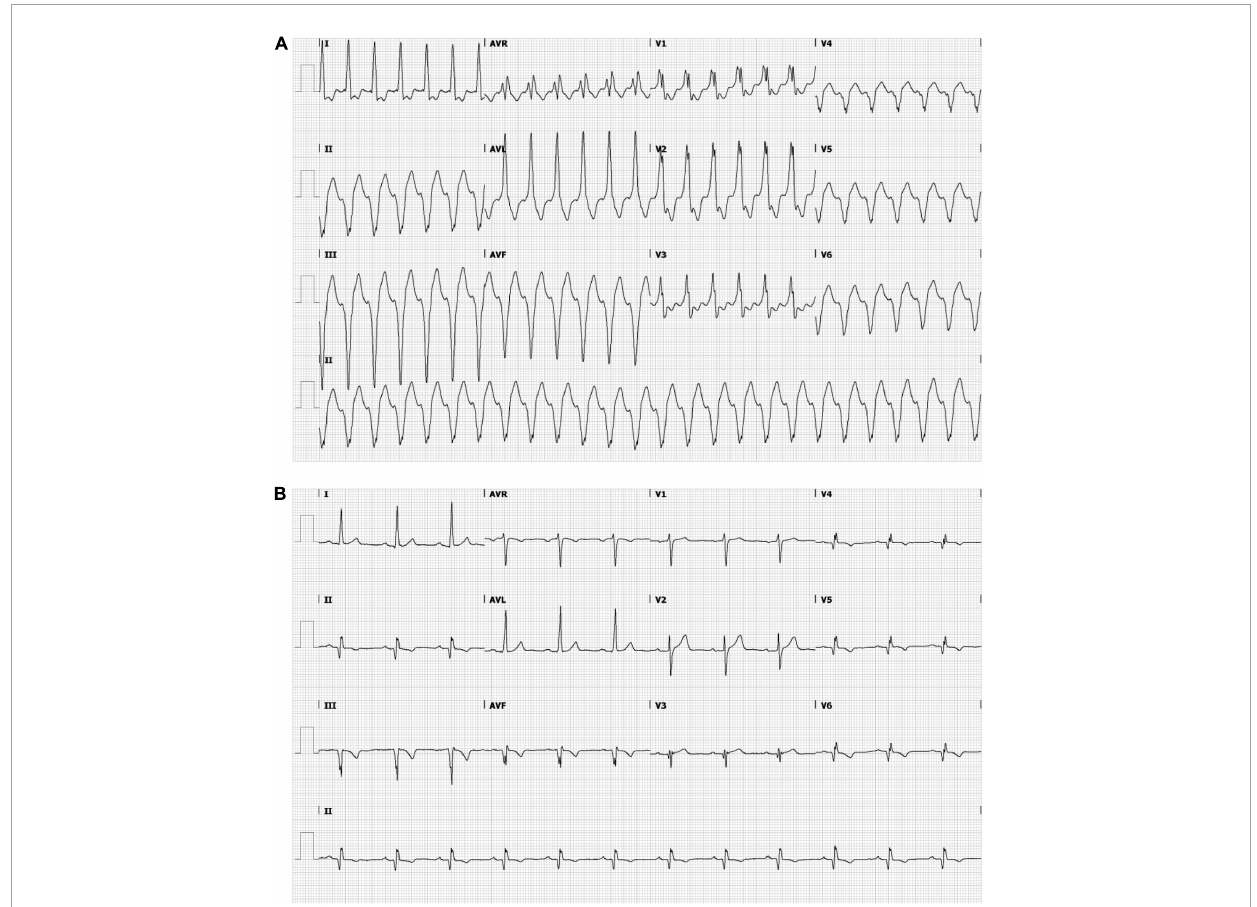
FIGURE1 Ensure that all the figure captions are correct, and that all figures are of the highest quality/resolution. If necessary, you may upload improved figures to the Production Forum. Please note that figures must be cited sequentially, per the author guidelines. The patient’s electrocardiogram during ventricular tachycardia (VT) (A) and sinus rhythm (B) . (A) Monomorphic VT demonstrating a wide QRS complex of 151 bpm with a right bundle branch block pattern (transition in V3) and a superior axis. The positive polarities in leads I and aVL suggest an inferomedial to inferobasal, septal origin (47). (B) Sinus rhythm, 72 bpm, left axis deviation, a QRS width of 112 ms, pathological Q waves in inferior leads and V3–V6 and negative T waves in inferior leads and in V4–V6. Q waves are indicative of previous inferior/apical